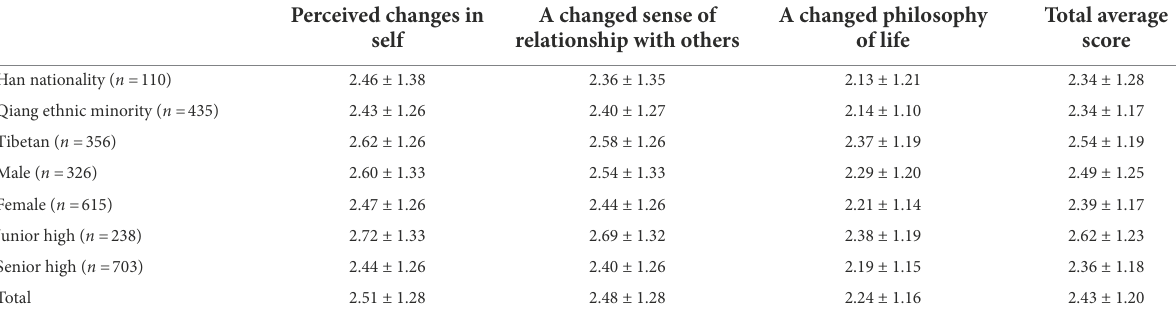
TABLE 1 PTG among adolescents in Wenchuan area during the COVID-19 pandemic (M ±